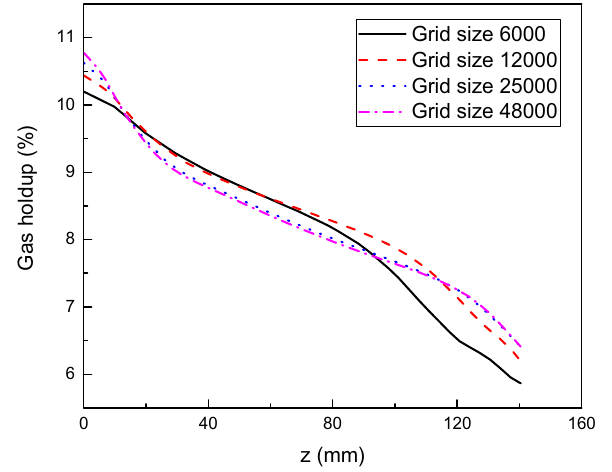
Figure 2. Gas holdup distributions with four types of grids.